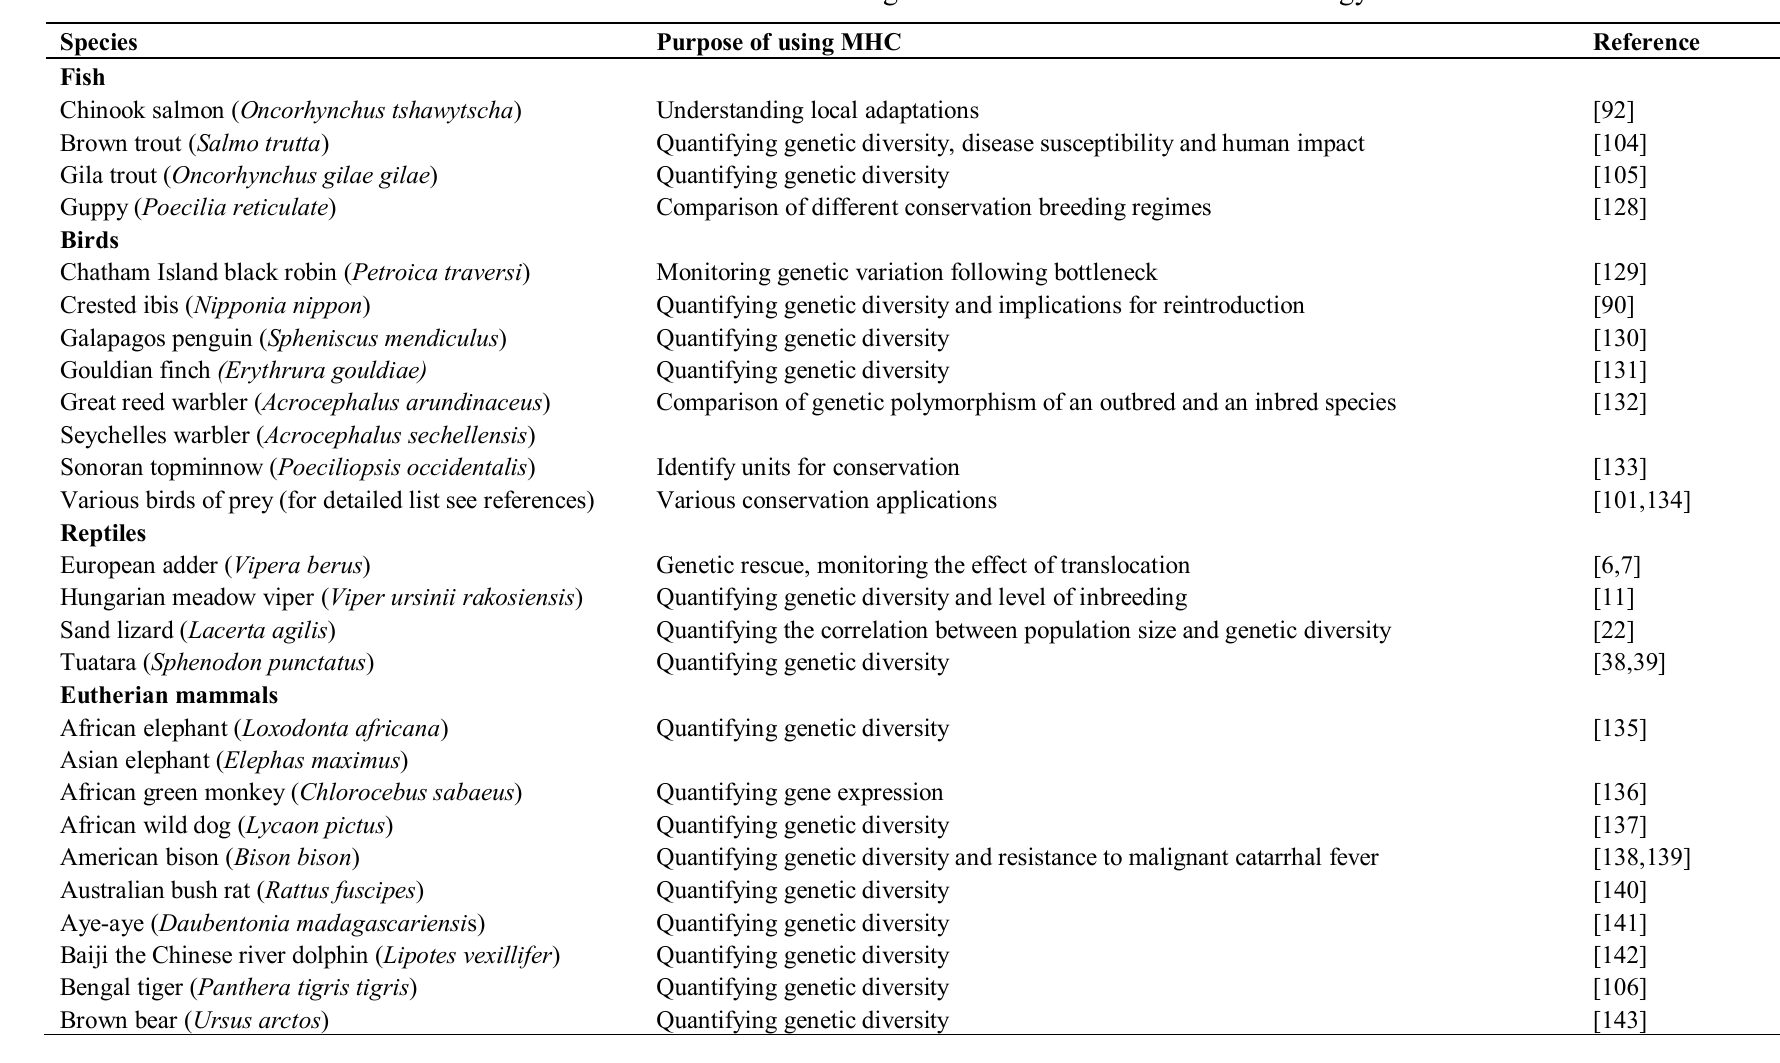
Table 1. A selection of studies using MHC markers in conservation